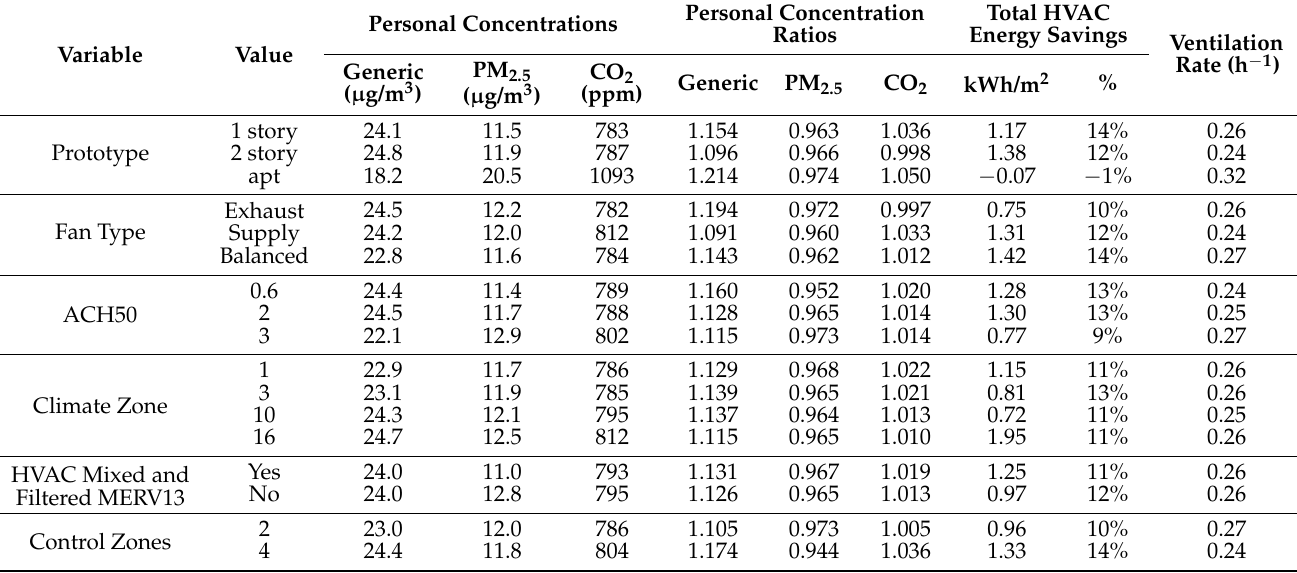
Table 6. Median personal concentrations, concentration ratios, and energy savings aggregated by simulation parameters. Smart control cases